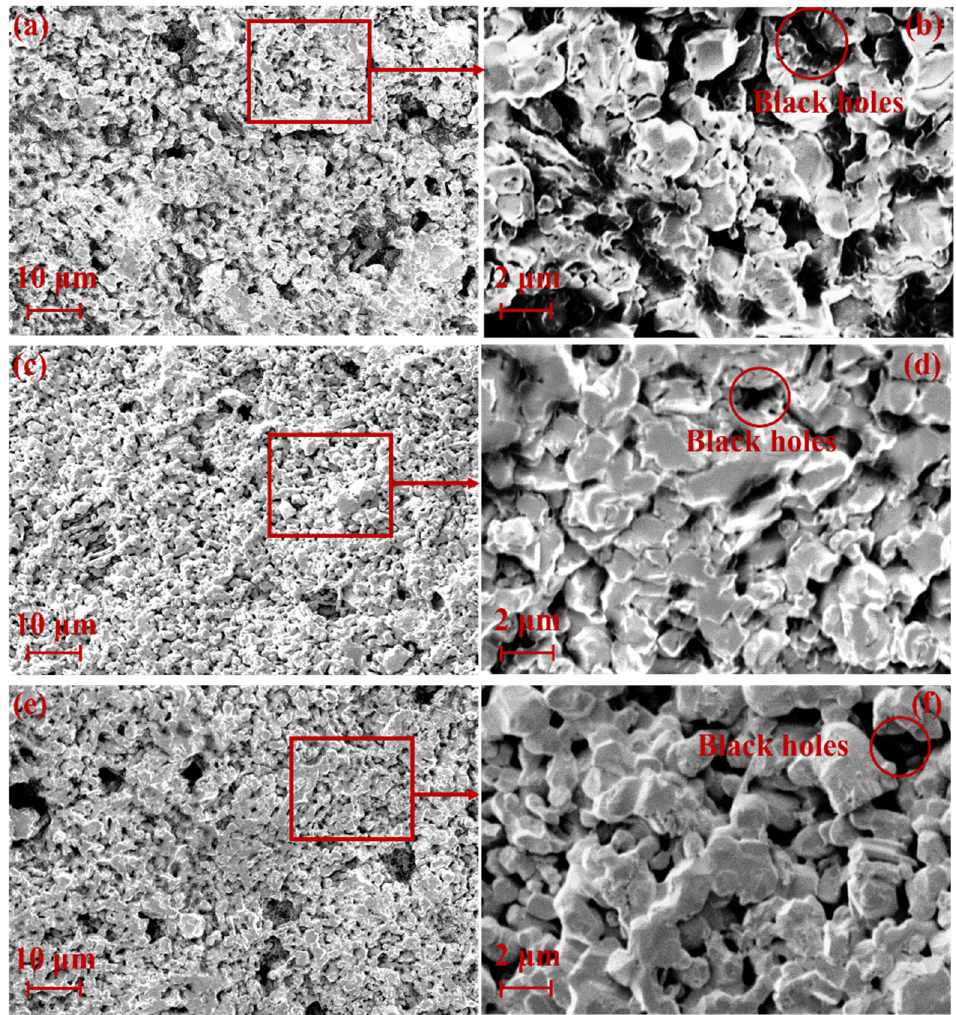
Figure 4. SEM images of the Sn-x type sintered ceramics: ( a , b ) Sn1, ( c , d ) Sn2, ( e , f ) Sn3.